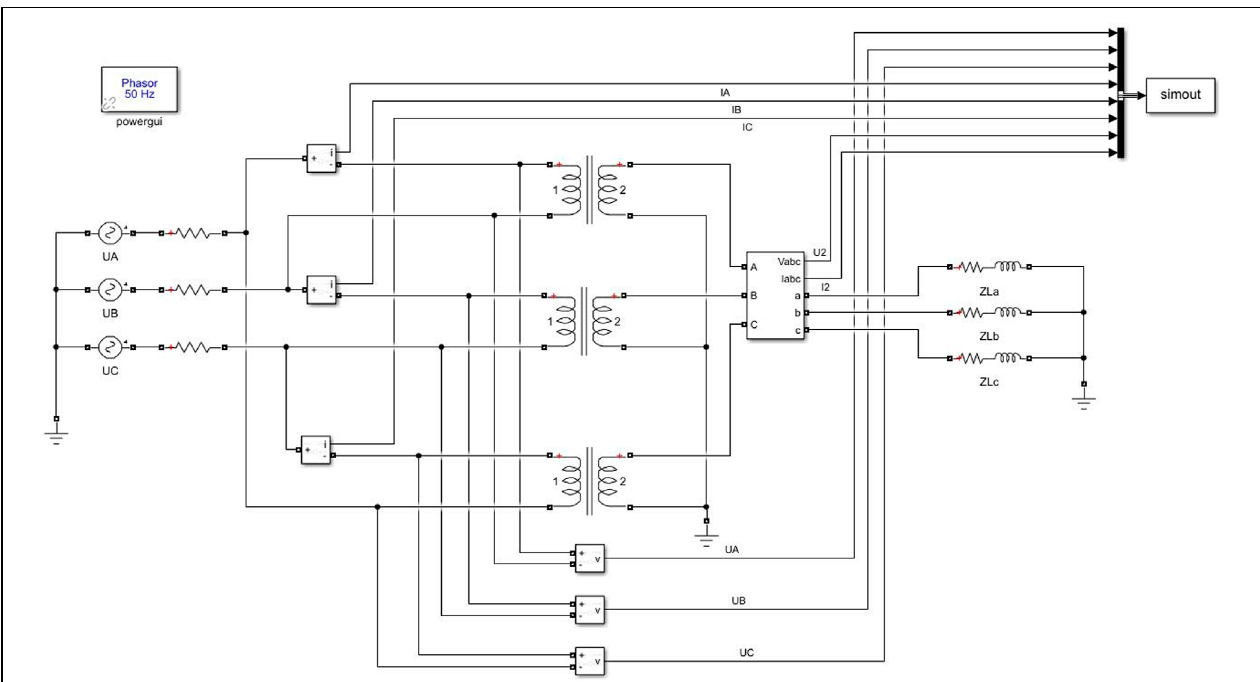
FIGURE 3 | Simulink transformer simulation circuit diagram.